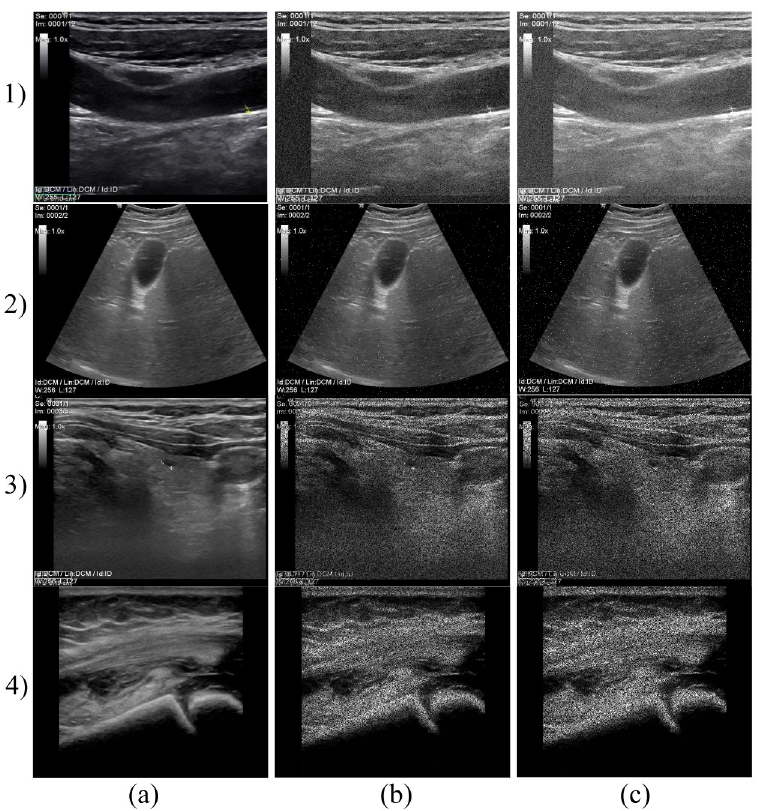
Fig 3. Examples of native images from different databases (a) and deteriorated by various types and levels of noise (b, c). 1) Gaussian noise applied on carotid ultrasound images: (b) Gaussian noise level ( σ 2 = 0.01, μ = 0.1) and (c) Gaussian noise level ( σ 2 = 0.01, μ = 0.2); 2) Salt and Pepper noise applied on abdominal ultrasound images: b) Salt and Pepper noise density ( d = 0.1) and c) Salt and Pepper noise density ( d = 0.2); 3) and 4) speckle noise applied on neck (3) and MSK (4) ultrasound images: b) variance of speckle noise ( σ 2 = 1) and c) variance of speckle noise ( σ 2 =